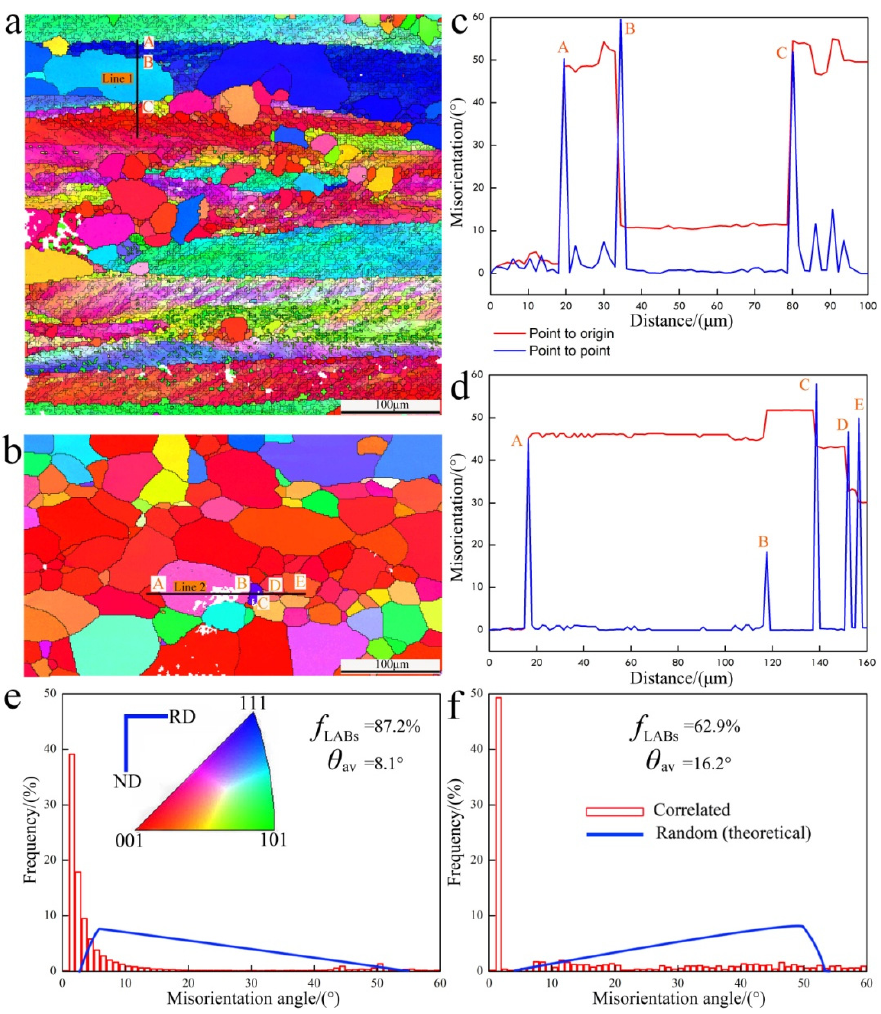
Figure 6. Orientation image and misorientation angle distribution with different heating rates of annealing ( a ) CR-70%, V = 60 ◦ C/min, T = 350 ◦ C; ( b ) CR-85%, V = 60 ◦ C/min, T = 350 ◦ C; ( c , d ) misorientation angle corresponding to ( a , b ); ( e , f ) misorientation angle corresponding to ( a , b